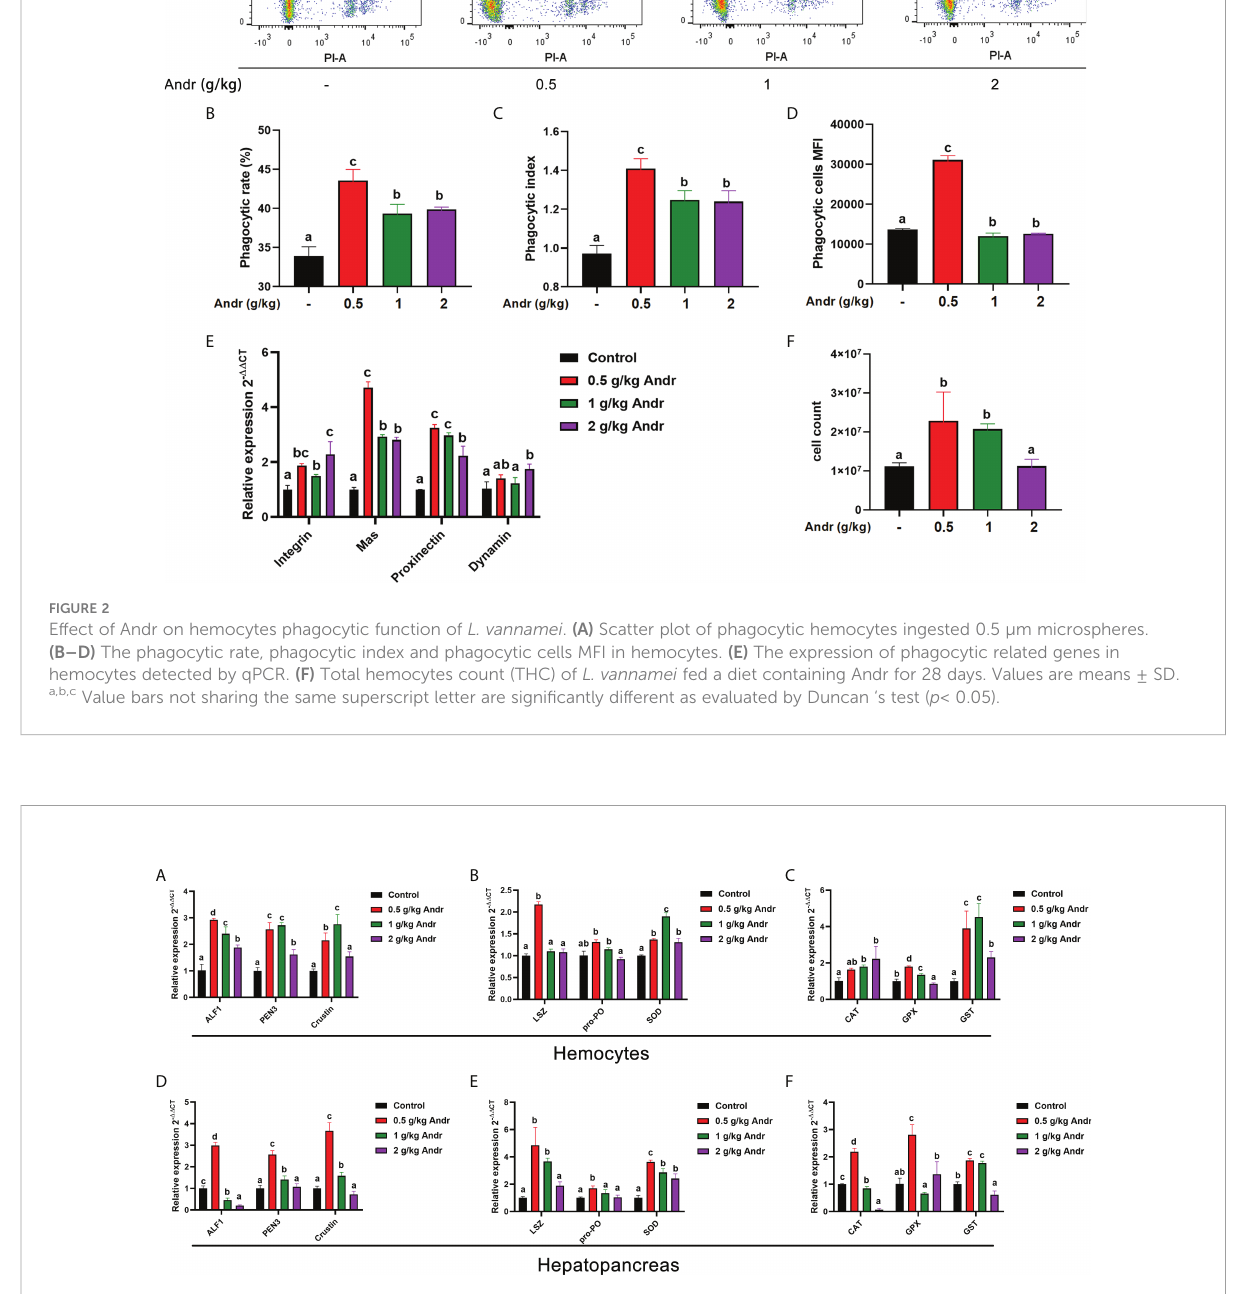
FIGURE 3 Effect of Andr on Immune-related gene in hemocyte and hepatopancreas of L. vannamei. (A, D) antimicrobial peptides; (B, E) immune functional proteins; (C, F) antioxidant protein. ALF1, Anti-lipopolysaccharide factor 1; PEN3, Penaeidin-3; LSZ, lysozyme; pro-PO, phenol oxidase; SOD, superoxide dismutase; CAT, catalase; GPX, glutathione peroxidase; GST, Glutathione S-transferase. Values are means ± SD. a,b,c,d Value bars not sharing the same superscript letter are signi fi cantly different as evaluated by Duncan ‘ s test ( p <